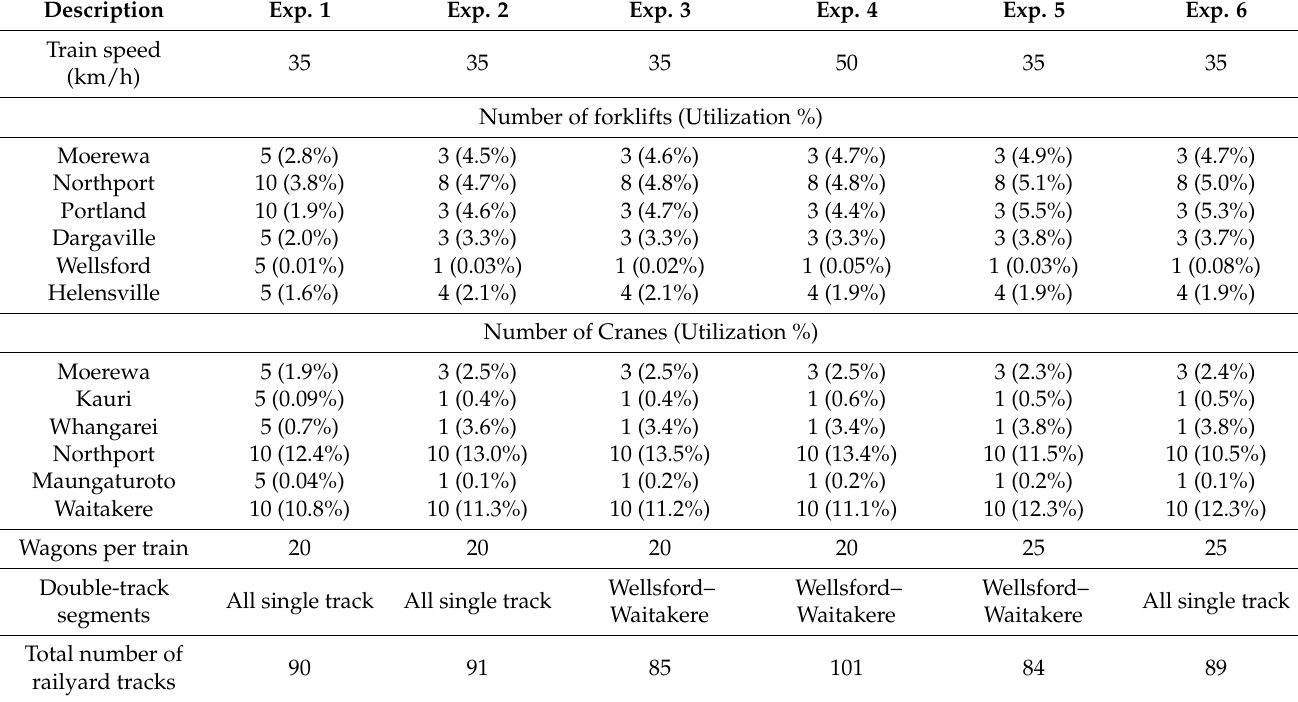
Table 1. Setup and terminal resource utilization for different simulation